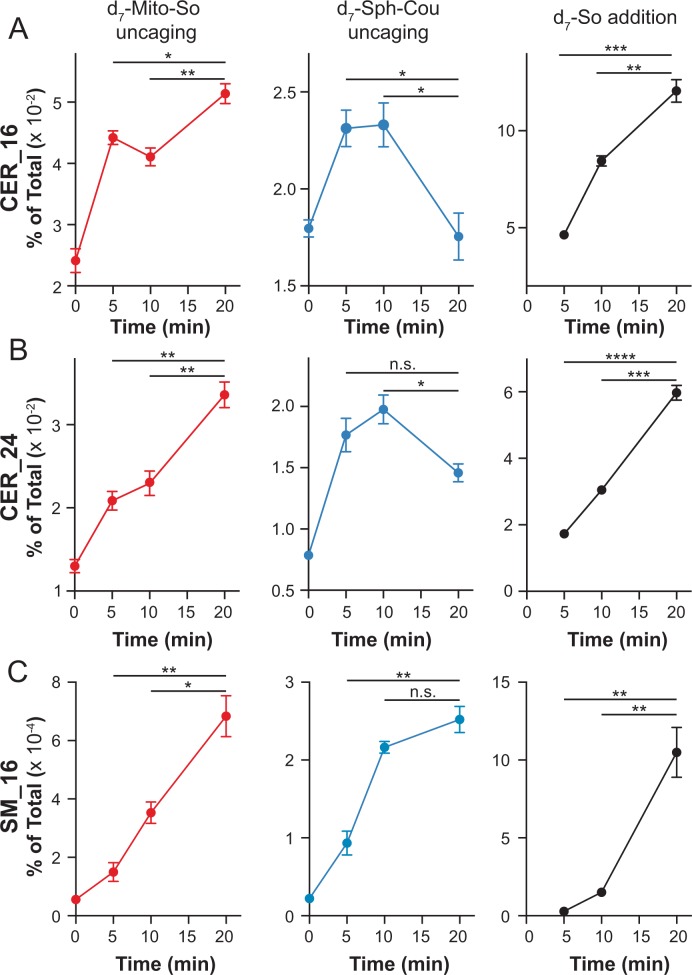
Real-time detection of d7-sphingolipids in living Hela cells after uncaging of d7-Mito-So, d7-Sph-Cou or direct addition of d7-sphingosine.Values were normalized with respect to the amount of internal standards and were plotted as percentage of all lipid signals. Data represent the average of three independent experiments. Error bars represent SEM. *p<0.05, **p<0.01, ***p<0.001, ****p<0.0001, n.s., not significant, students' t-test.